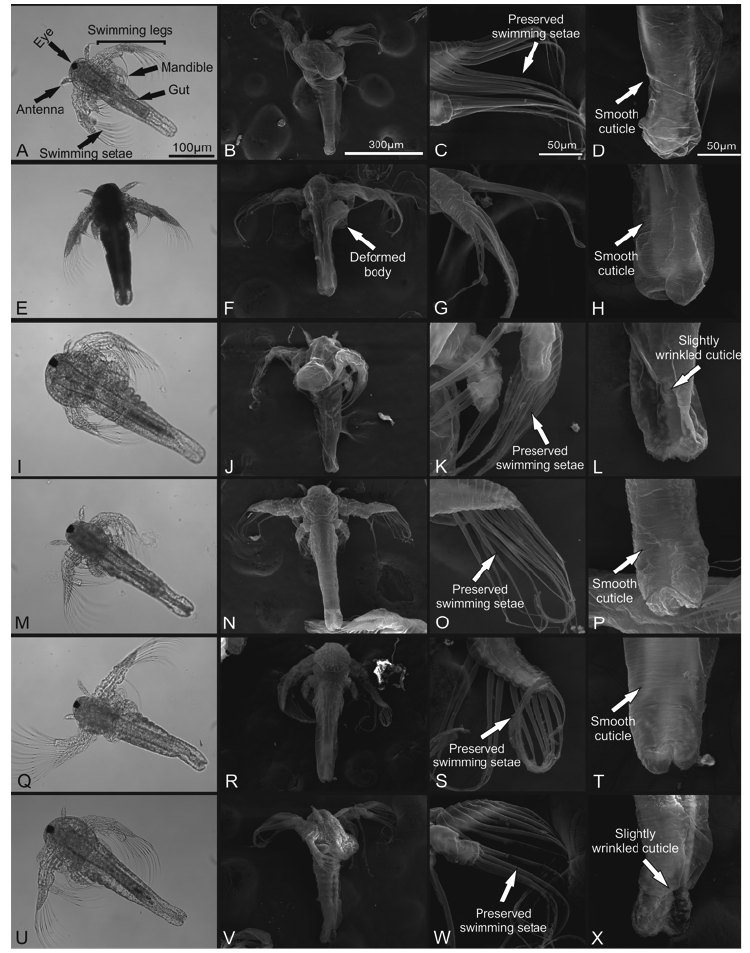
Figure 7. Optical and scanning electron microscopy of A. salina nauplii within 24 h exposure on acute toxicity test. ( A – D ) Negative control (artificial seawater); ( E – H ) positive control (K 2 Cr 2 O 7 0.5 M); I-L fresh cashew bagasse 1000 μ g/mL; ( M – P ) 75 W/cm 2 cashew bagasse 1000 μ g/mL; ( Q – T ) 226 W/cm 2 cashew bagasse 1000 μ g/mL; ( U – X ) 373 W/cm 2 cashew bagasse 1000 μ g/mL . Note severe damage on nauplii exposed to K 2 Cr 2 O 7 . Bars: ( A , E , I , M , Q , U )—500 μ m; ( B – D , F – H , J – L , N – P , R – T , V – X )—50 μ m.